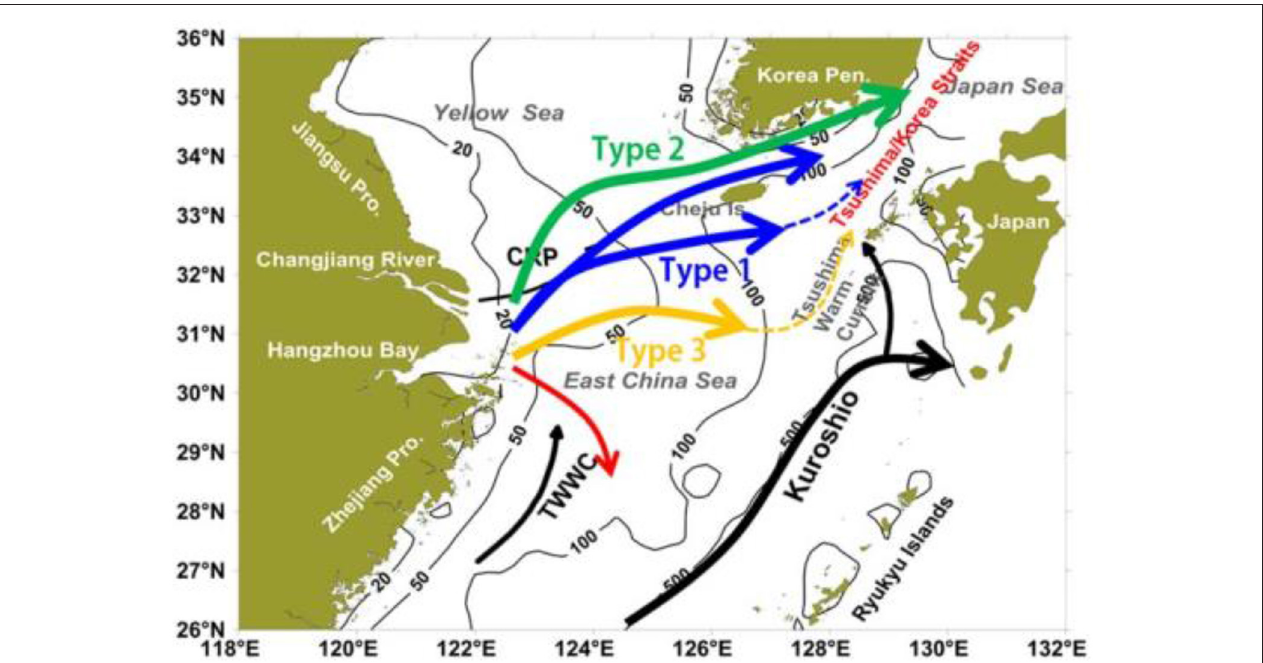
FIGURE 4 | Schematic pathways (colored arrows) of the three types of Changjiang River Plume identified from the 31 psu isohalines. The dashed arrows in blue and yellow signify plume water higher than the 31 psu would have advected by the Tsushima Warm Current to the Tsushima-Korea Straits. The red arrow shows the occasional movement triggered by typhoons. This figure is adapted from Bai et al. (2015), and Type 1 stands for the most frequently observed pathway of the plume, while Type 2 shows the pathway of buoyant waters when the buoyant waters are extensively advected toward Tsushima Strait, without residing over the shelf. Type 3 is rarely observed southeastward motion of the buoyant